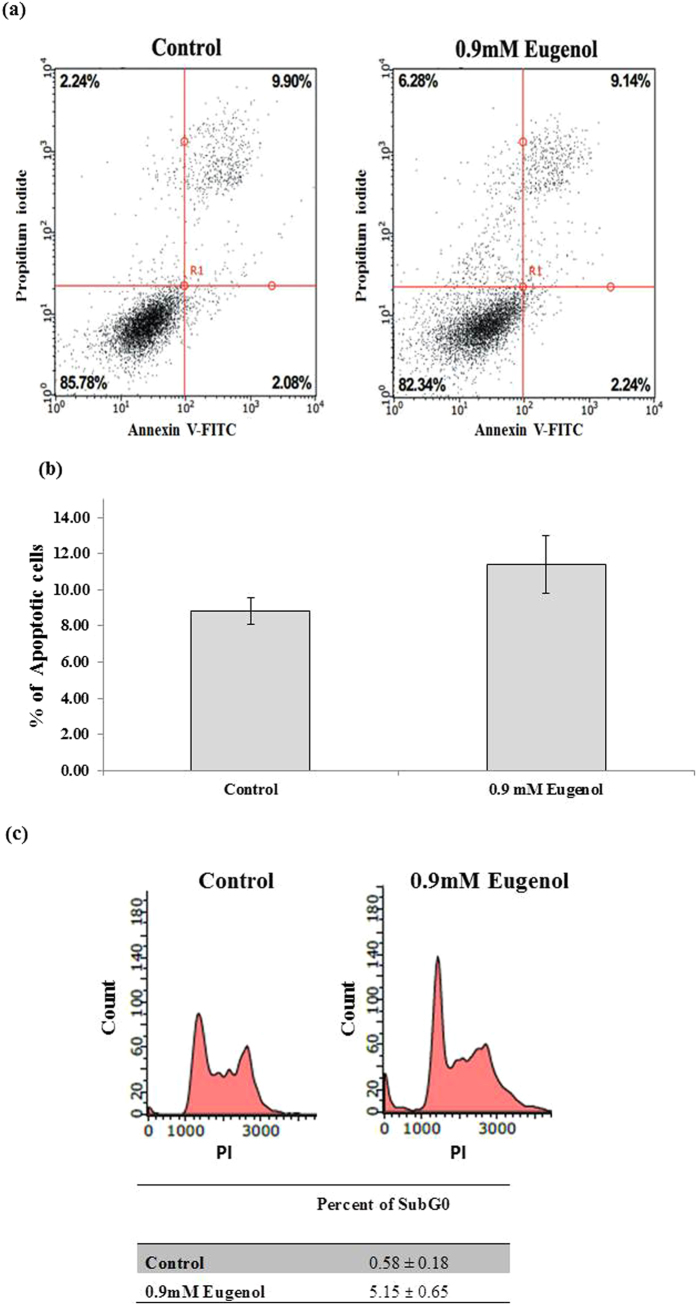
(a) Representative dot plots of cell apoptosis for control (vehicle treated: ethanol) and eugenol (0.9 mM) treated MCF-7 cell after Annexin V/PI dual staining. The proportion of dead cells (Annexin V−/PI+), live cells (Annexin V−/PI−), early apoptotic cells (Annexin V+/PI−) and late apoptotic/necrotic cells (Annexin V+/PI+) were measured and compared. (b) Percentage of early and late apoptotic MCF-7 cells. Each value represents the mean ± SEM of two different experiments; *P value < 0.05 was considered significant compared to a control cells. (c) Representative histogram on the effect of eugenol on MCF-7 cell cycle distribution as measured by PI flow cytometry, compared to control. Each value represents the mean ± SEM of two different experiments; *P value < 0.05 was considered significant.